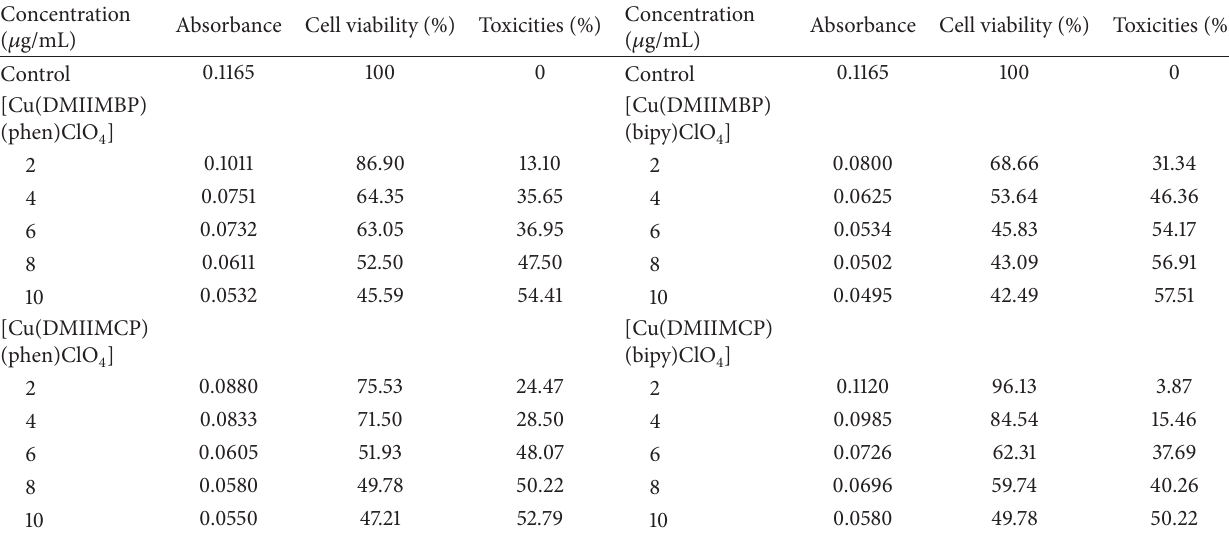
Table 8: In vitro cytotoxicity (HeLa cell line) of Cu (II) complexes.